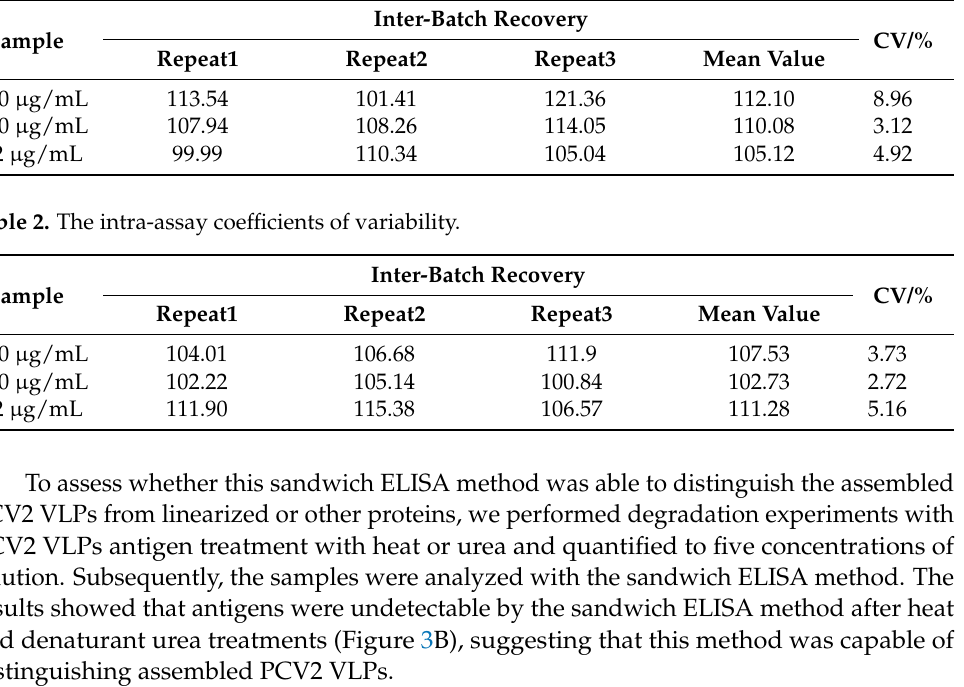
Table 1. The inter-assay coefficients of variability.